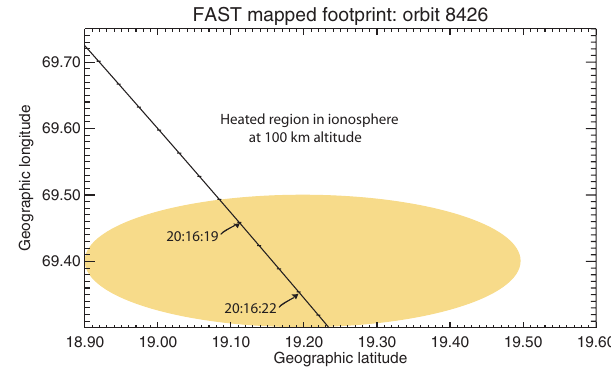
Fig.2. Fig. 2. FAST satellite track mapped from 2550km altitude down the field lines (using IGRF Tysganenko 1989 model) to 100km altitude. The shaded region represents the approximately circular heated re- gion (3dB level) at this altitude in the E-region ionosphere. The ticks mark each second of data; the arrows show times when a 3Hz signal was observed in the FAST data shown in Fig.